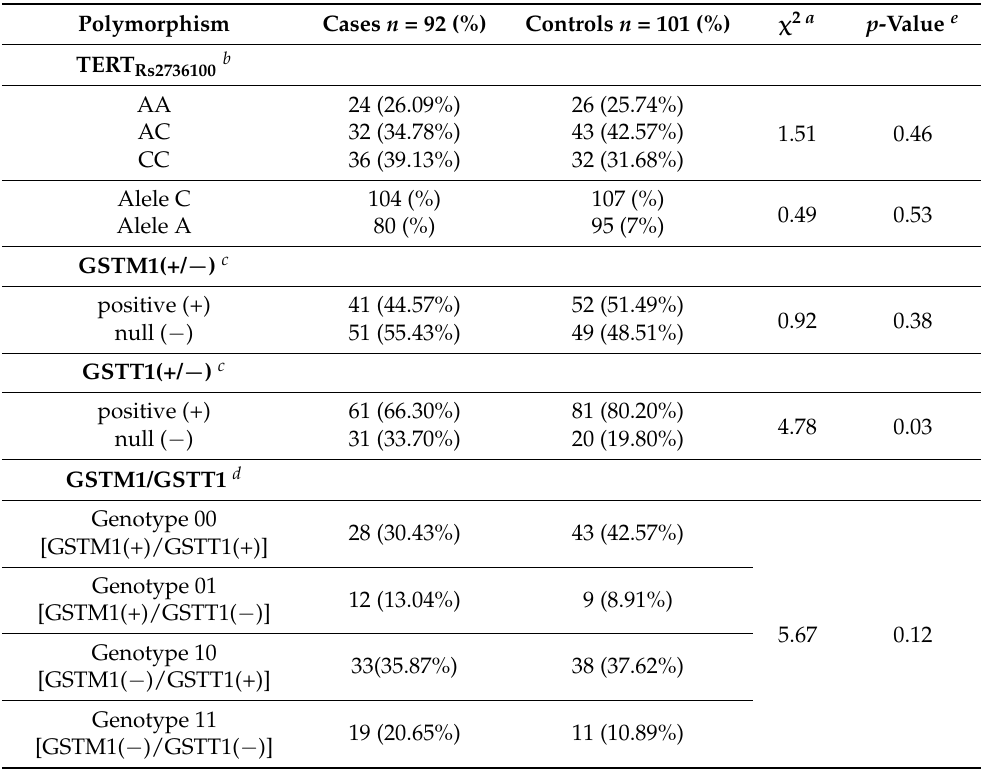
Table 3. Genotype and frequency distribution of TERT Rs2736100 , GSTM1, and GSTT1 genotypes in subjects and